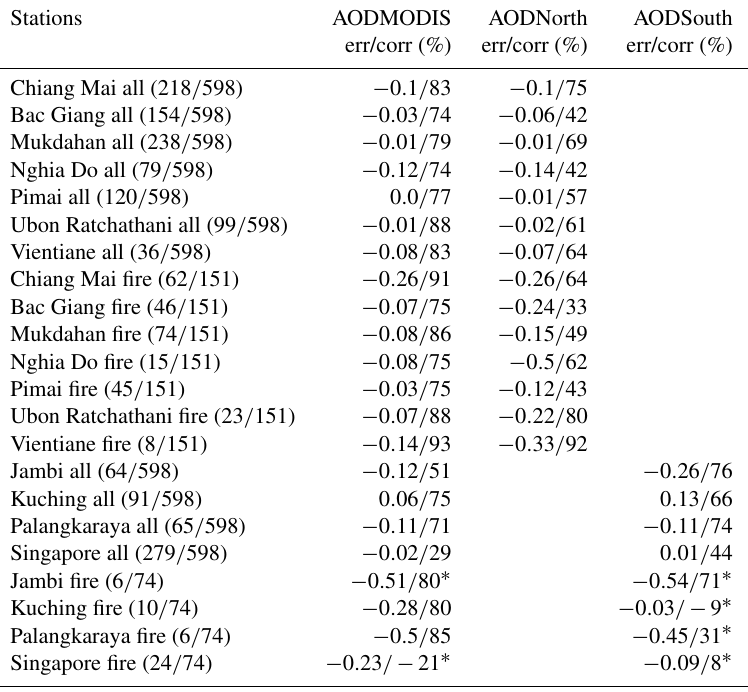
Table 2. Statistics over the respective northern and southern regions compared to the AERONET stations. Overlapped periods between the reconstructed AOD AODNorth/South and AERONET are stated in parenthesis. “Fire” denotes data analyzed only during the fire season, while “all” denotes the entire data set. Stations